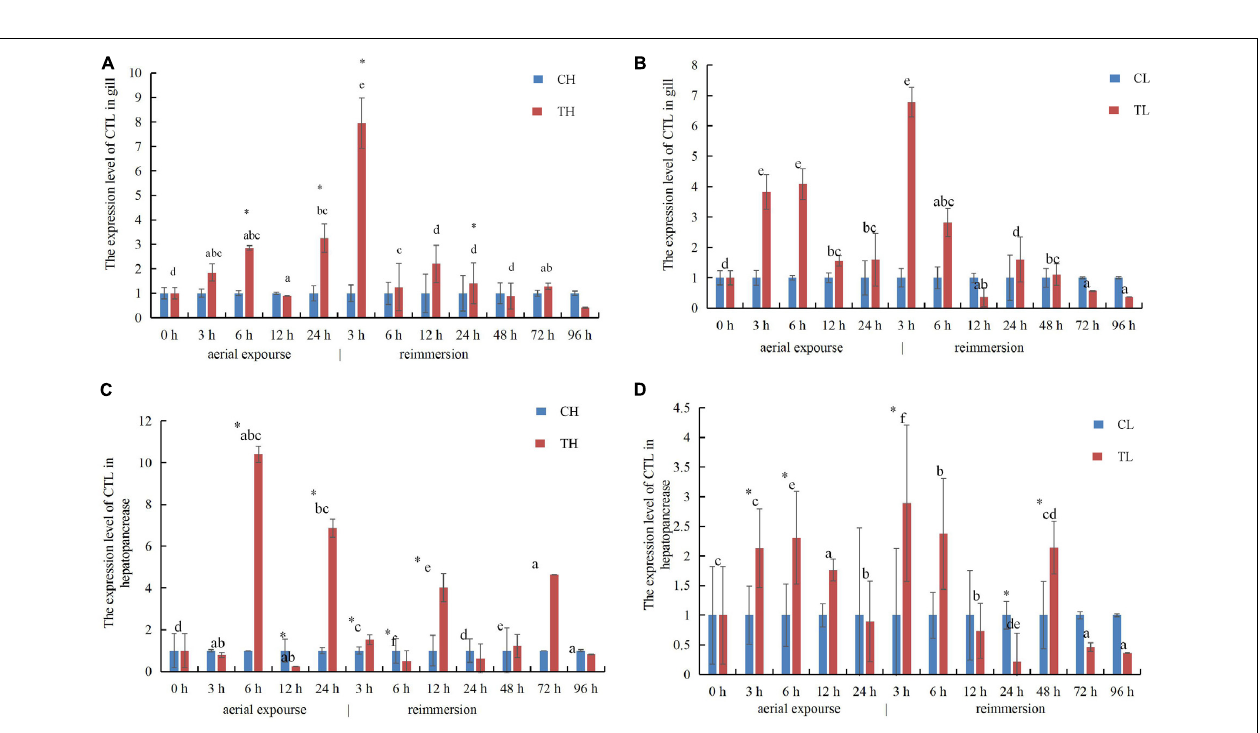
Frontiers in Physiology |